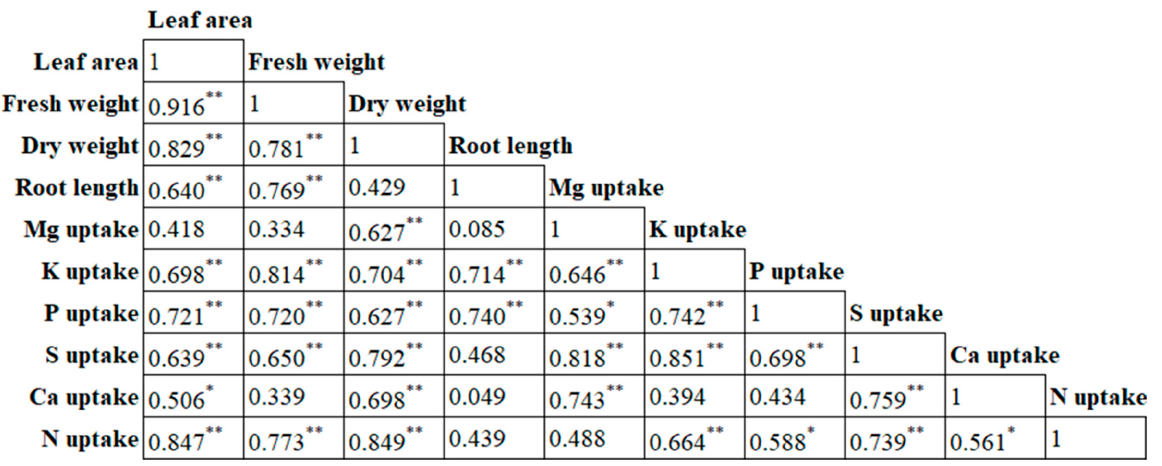
Figure 3. Correlations among plant growth parameters and plant nutrient uptake. Pearson’s correlation coefficients are presented. “*” denotes p < 0.05 and “**” denotes p < 0.01.